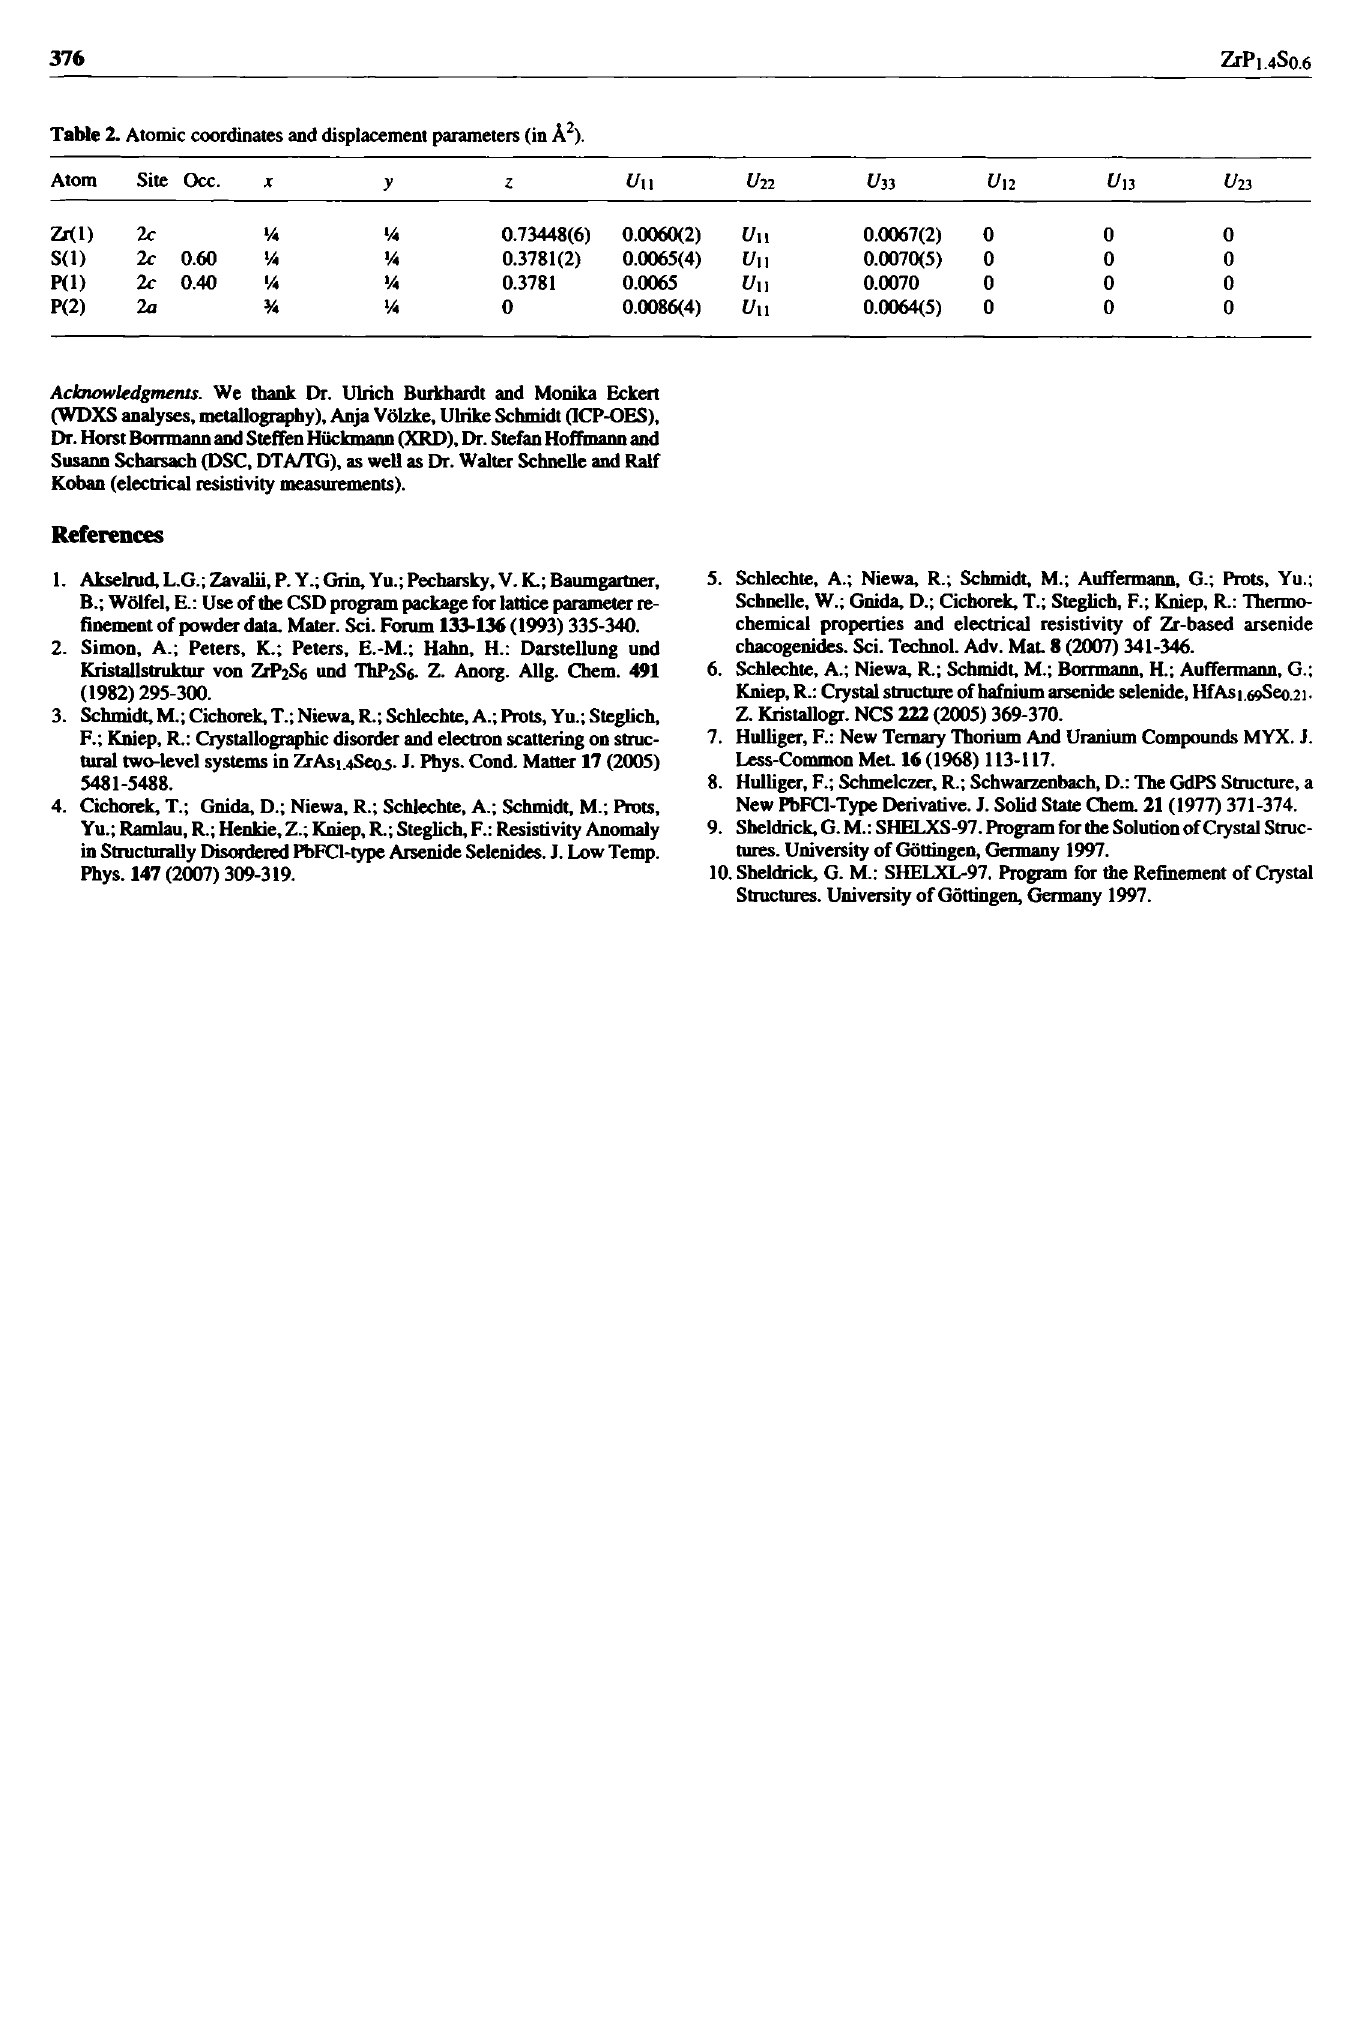
Table 2. Atomic coordinates and displacement parameters (in Â 2